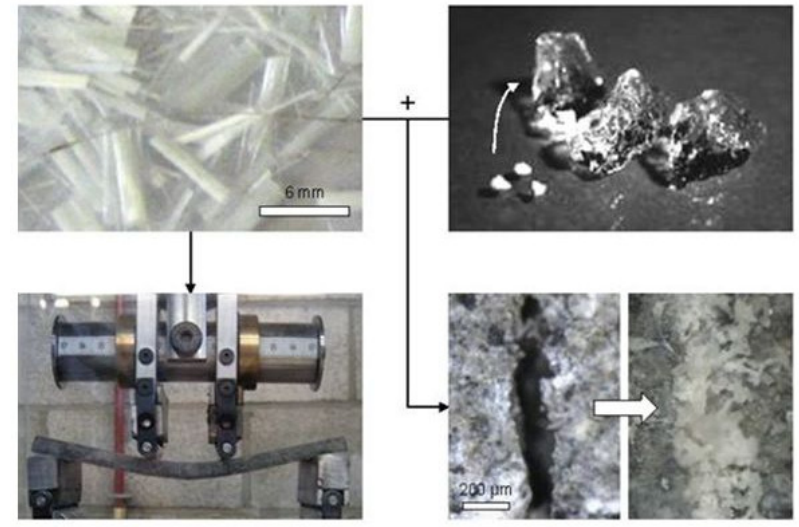
Figure 2. General overview of the combination of microfibers and SAPs to receive multiple cracking with small healable cracks and the stimulation of autogenous